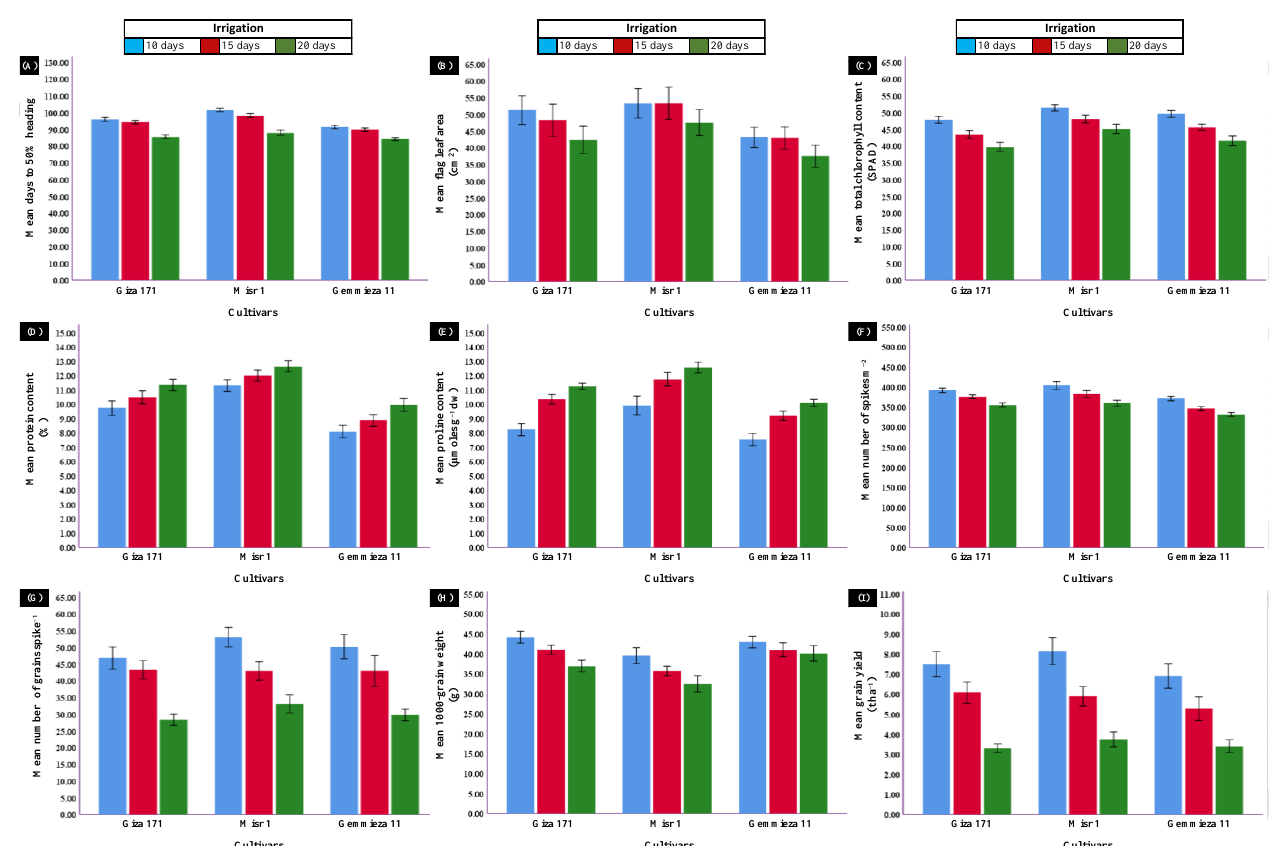
Figure 3. Error bar chart showing the effect of the interaction between irrigation and cultivars on ( a ) mean days to 50% heading, ( b ) mean flag leaf area (cm 2 ), ( c ) mean total chlorophyll content (SPAD), ( d ) mean protein content (%), ( e ) mean proline content (µmoles g −1 dw), ( f ) mean number of spikes m −2 , ( g ) number on grains spike −1 , ( h ) mean 1000 grain weight (g), ( i ) mean grain yield (t ha −1 ).